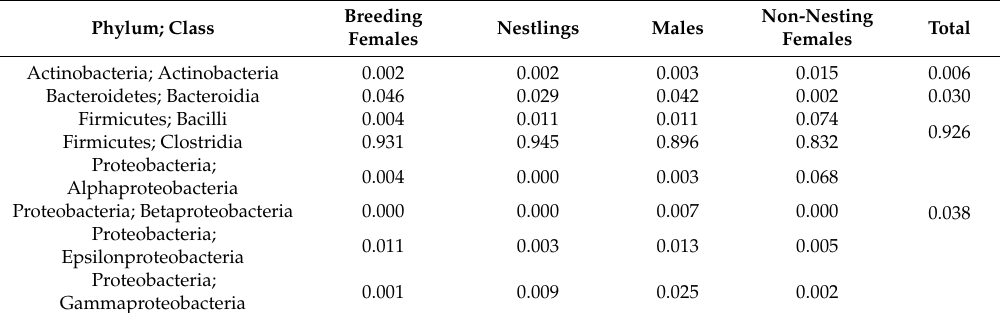
Table 2. Average bacterial composition at class level (in proportion of sequences) of hoopoe uropygial microbiota for breeding females, nestlings, males, and non-nesting females. The average for the total sampled hoopoe population is given at phylum